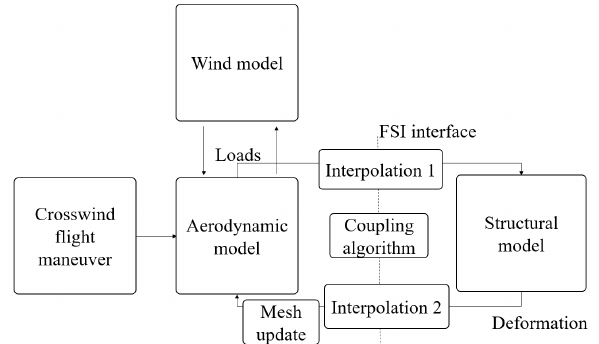
Figure 3. Overview of the partitioned FSI approach and interaction with sub-components to assess wing deformation of an AWE system in crosswind flight.